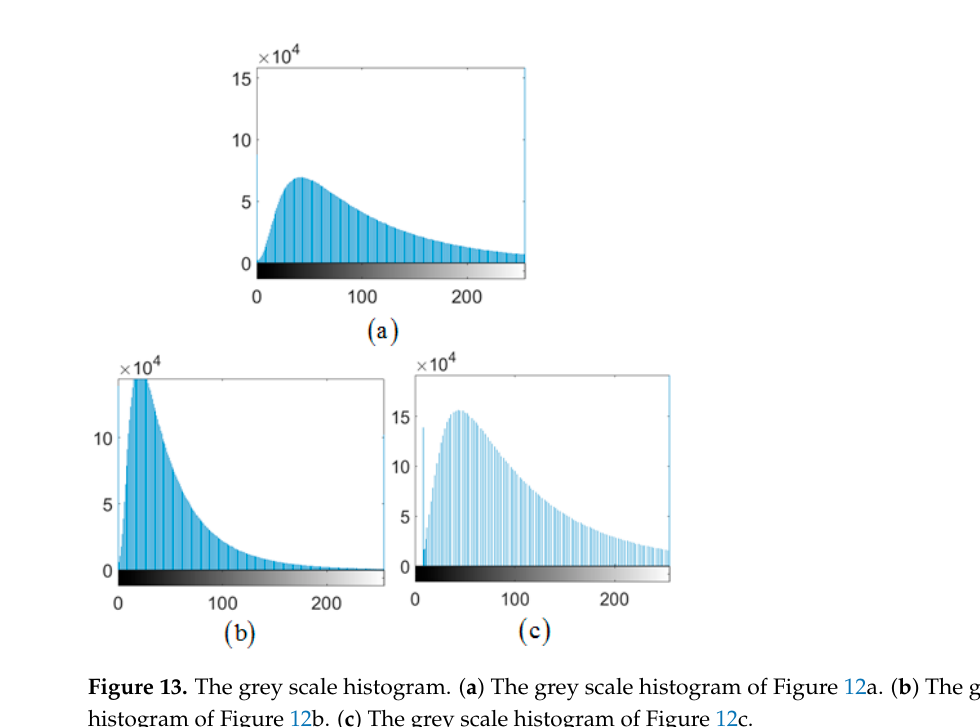
Figure 12. The grey scale between different frame images. ( a ) The reference image. ( b ) The original image. ( c ) The original image with energy balance.